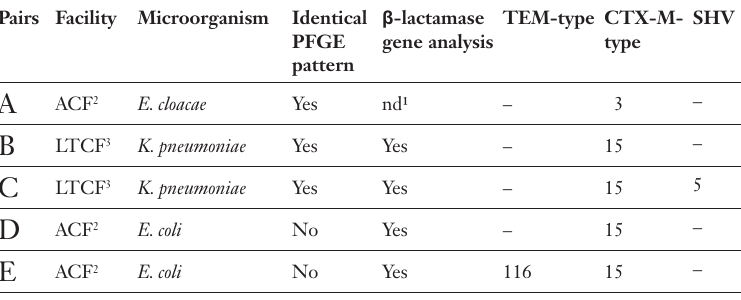
Characteristics of cross-transmission pairs analysed by pulse-field gel electrophoresis (PFGE) and molecular gene determination. Pairs Facility Microorganism Identical PFGE